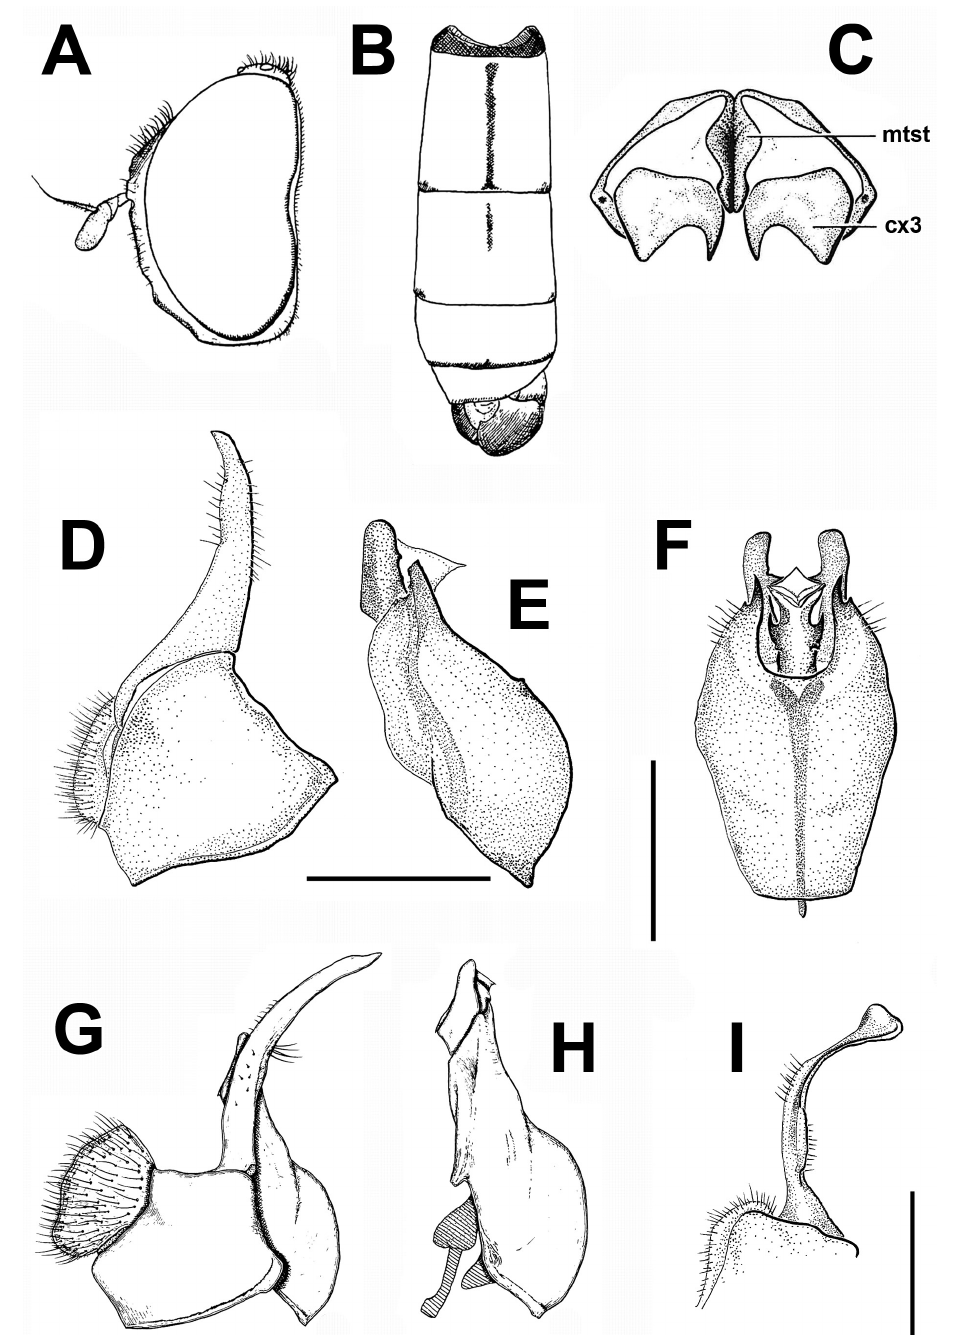
Fig. 9. A–B . Melanostoma apicale Bigot, 1884, ♂ (from Ôhara & Kusigemati 1985, as M. uni- vittatum (Wiedemann, 1824)). A. Head, lateral view. B. Abdomen, dorsal view. C. Melanostoma mellinum (Linnaeus, 1758), ♂, metasternum, ventral view (from Vockeroth & Thompson 1987; mtst = metasternum, cx3 = metacoxa). D–F . Melanostoma polynesiotes Mengual & Ramage sp. nov., holotype, ♂ (ZFMK-DIP-00019707), genitalia . D. Epandrium with surstylus and cercus, lateral view. E. Hypandrium, lateral view. F. Hypandrium, ventral view. G–H. M. apicale Bigot, 1884, ♂, genitalia, lateral view (from Ôhara & Kusigemati 1985, as M. univittatum (Wiedemann, 1824)). G. Epandrium with surstylus and cercus. H. Hypandrium. I . Melanostoma univittatum (Wiedemann, 1824), ♂ (ZFMK- DIP-00019737), surstylus and part of epandrium and cercus, lateral view. Scale bars = 0.5